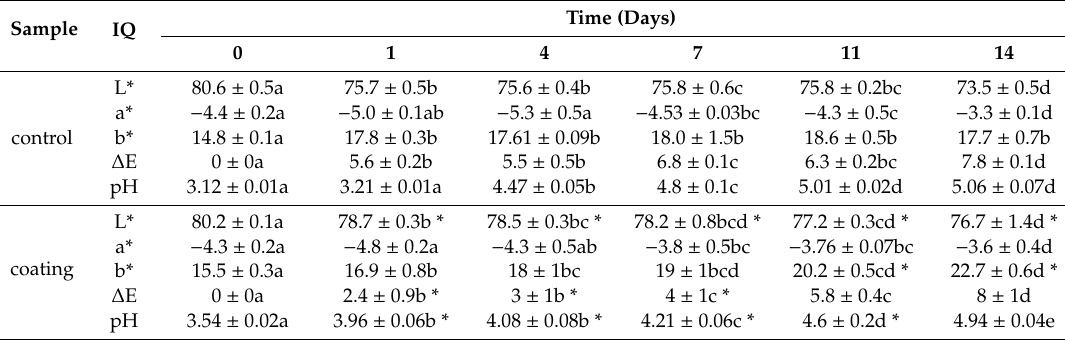
Table 1. Color (L*, a*, b*, ΔE) and pH of control and coated samples at different storage time. IQ = quality index.